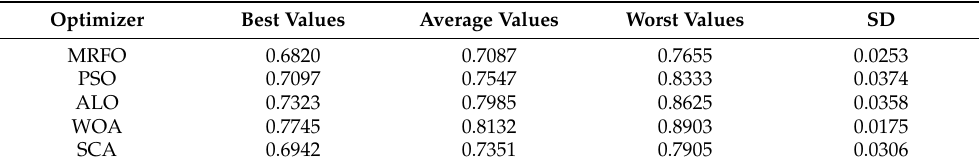
Table 7. The statistical results in the IEEE 118-bus system with the use of several